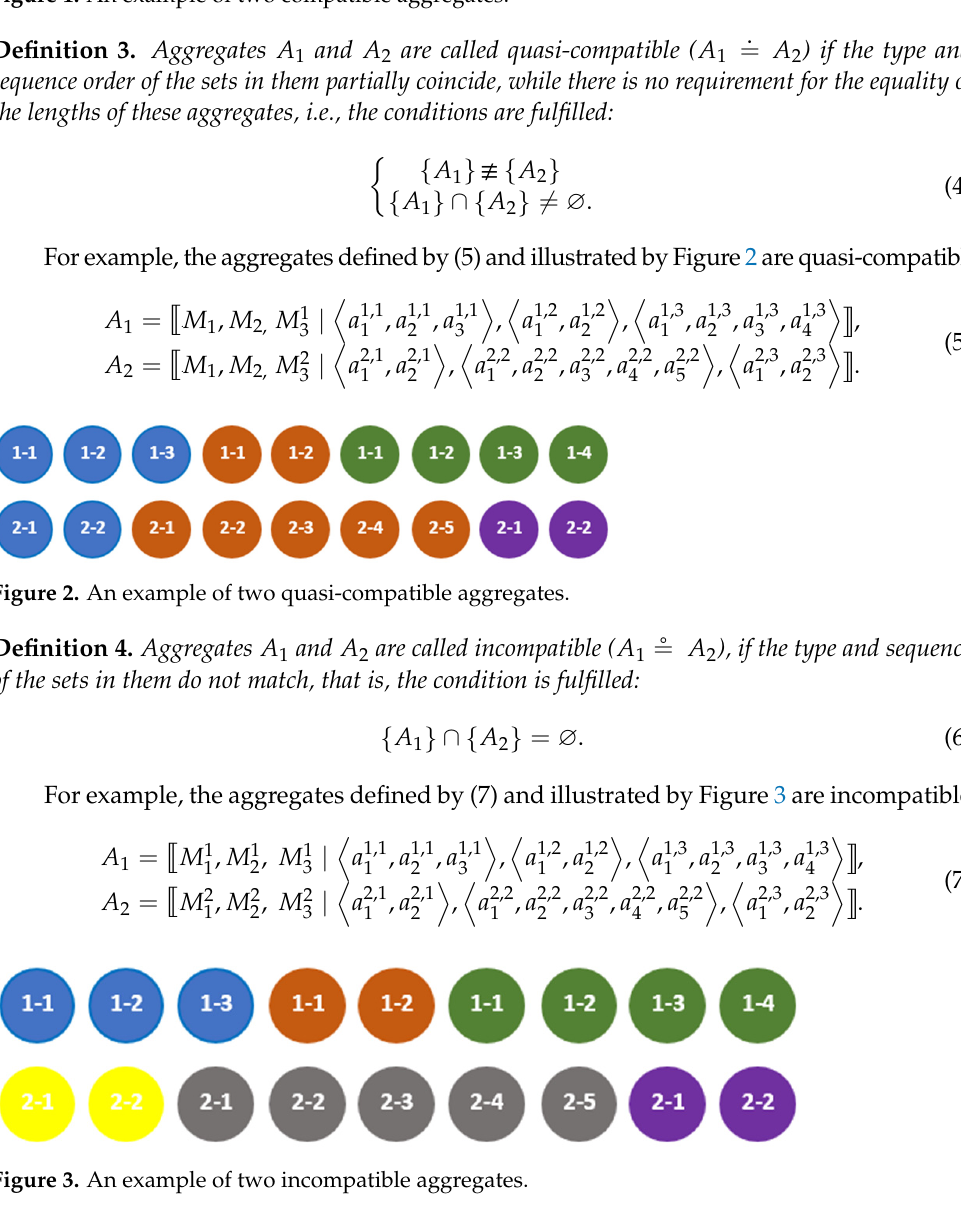
Figure 3. An example of two incompatible aggregates. Figure 1. An example of two compatible aggregates.